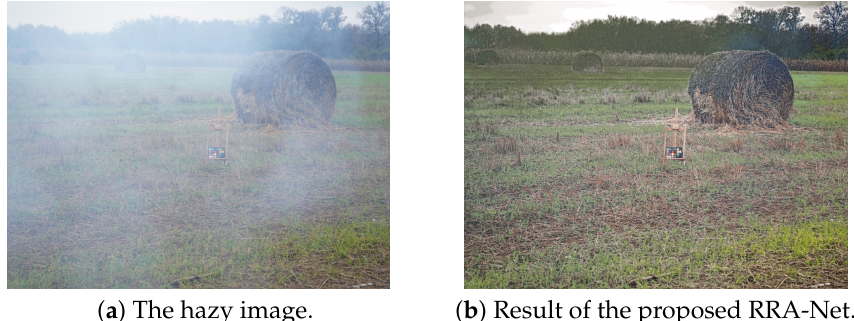
( a ) The hazy image. ( b ) Result of the proposed RRA-Net. Figure 1. Visual result of the proposed method on NH-Haze (2021) dataset. Our method is able to produce haze-free images with high perceptual quality.